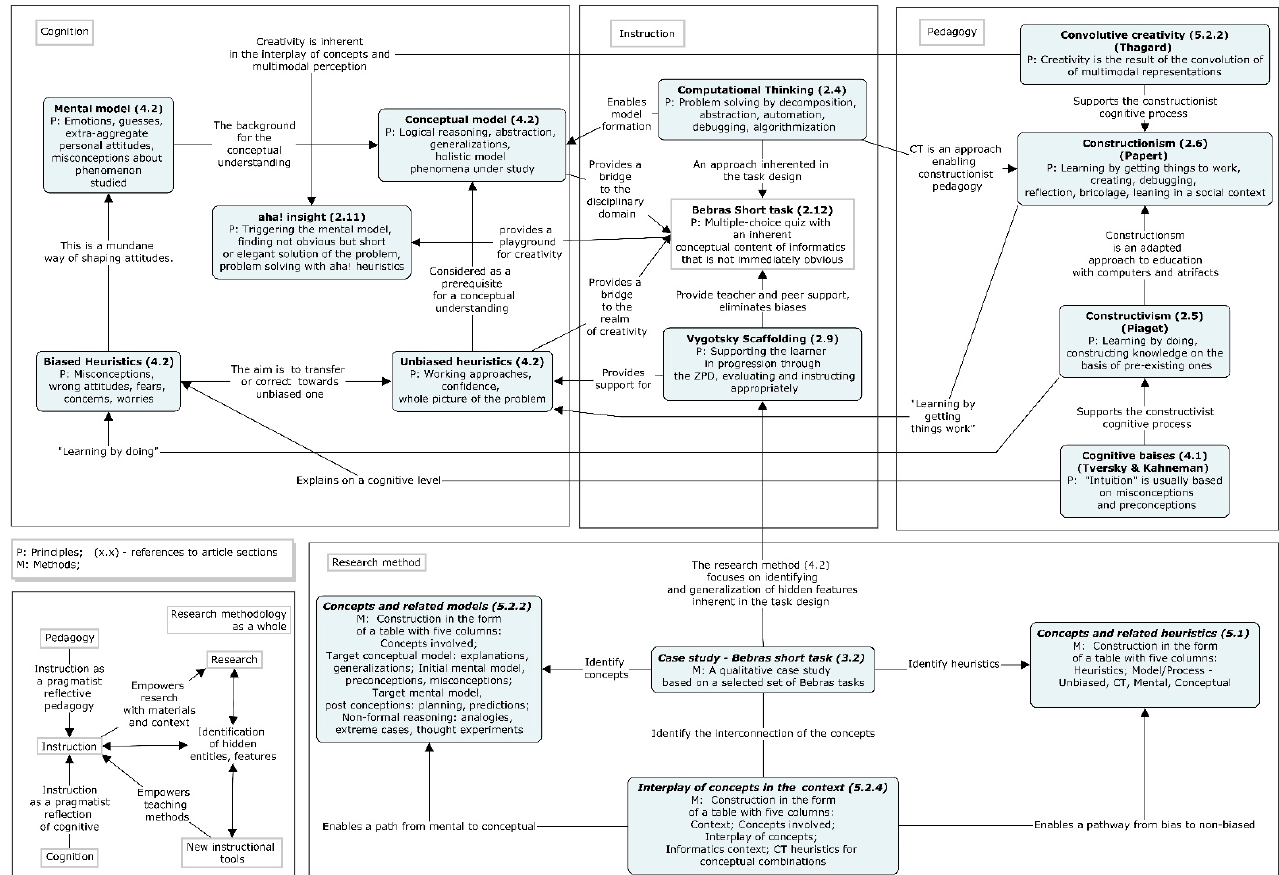
Figure 4. General overview of the implemented methodology (elaborated by the authors).